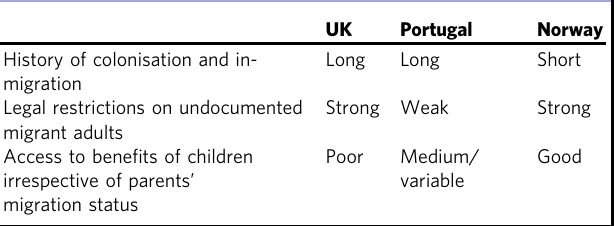
Table 1 Similarities and differences in the contexts that shape migrants ’ access to resources: UK, Portugal and